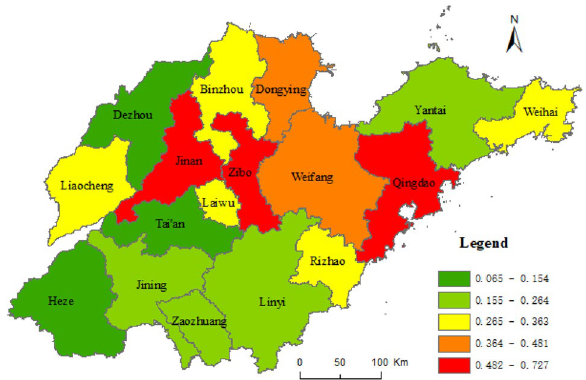
Figure 2. Urban–rural integrated level of Shandong province based on nighttime light data. This figure was created with ArcGIS 10.5 (URL: http:// www. esri. com/).